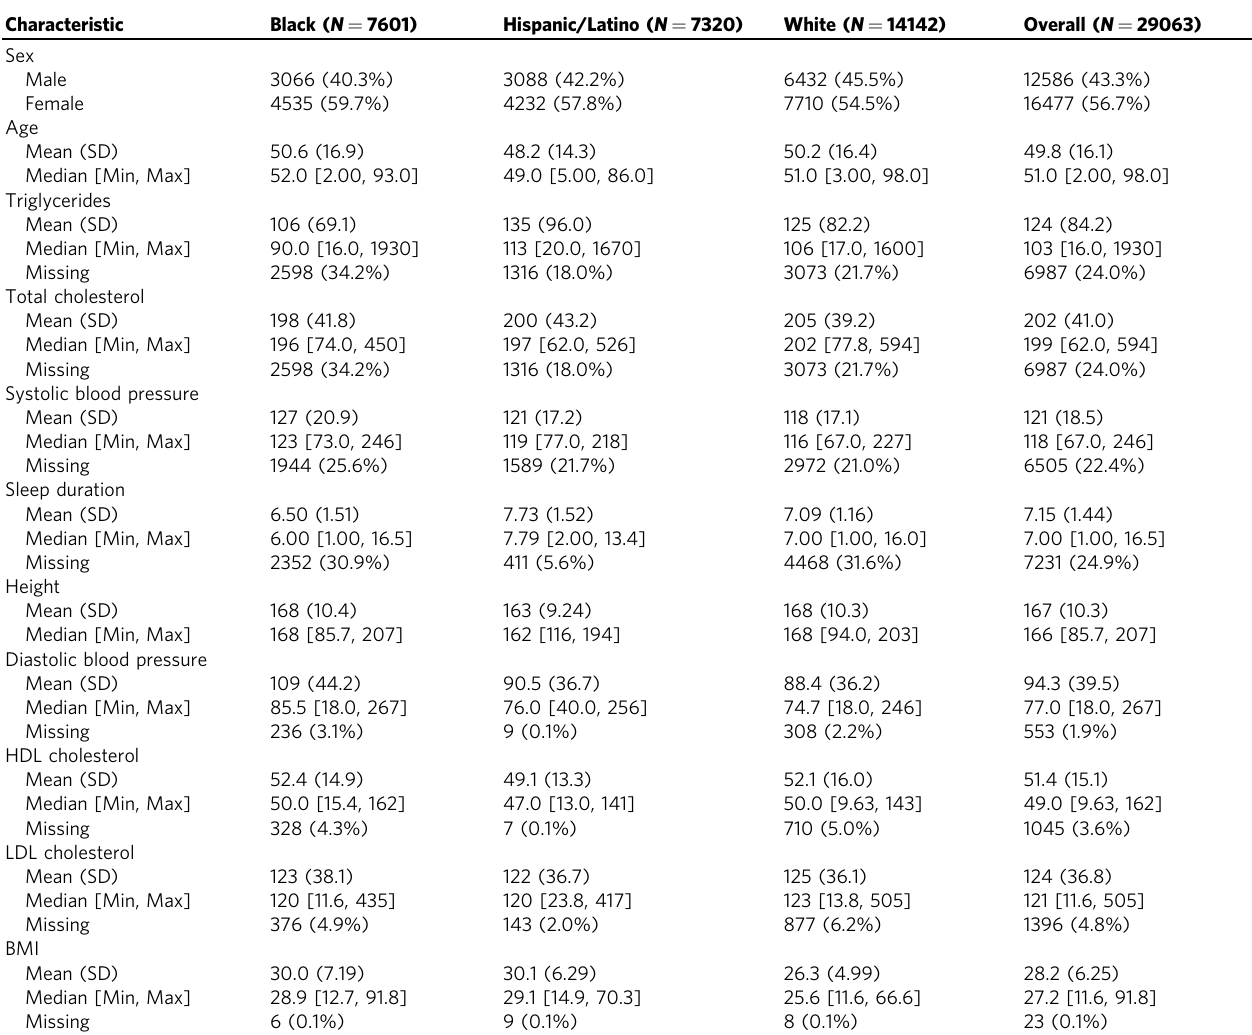
Mean,Median,andpercentofmissingdataforthephenotypesandcovariates(sexandage)usedinthisstudy.Mostmissingvaluesforsystolicbloodpressure,totalcholesterol,andtriglyceridesaredue to medication use. All the phenotypes are presented for the whole database as well as strati fi ed by race/ethnicity (Black, White, and Hispanic/Latino). Summary statistics for the test dataset are provided in Supplementary Table